Question: Describe this figure in one sentence.
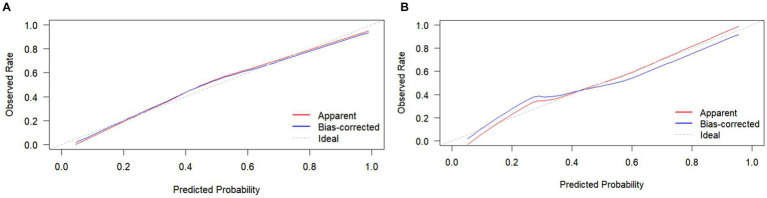
Answer: (A) Calibration curve of the training set. (B) Calibration curve of the validation set.